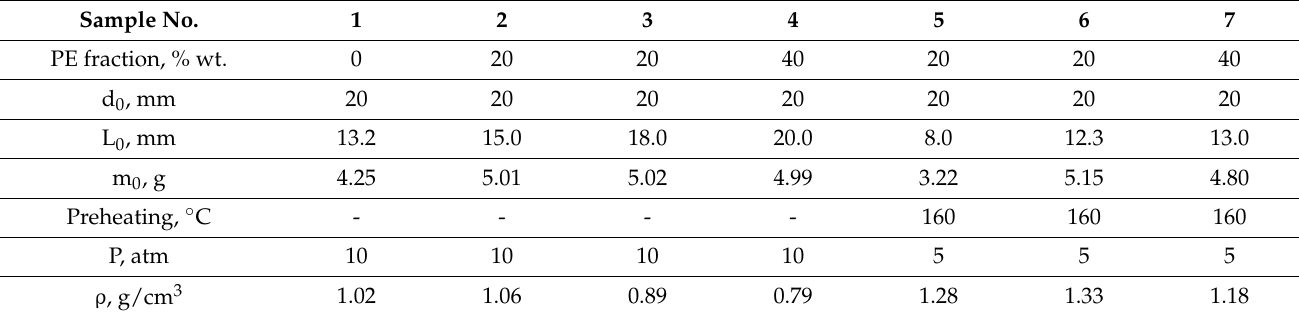
Table 1. Composition and properties of